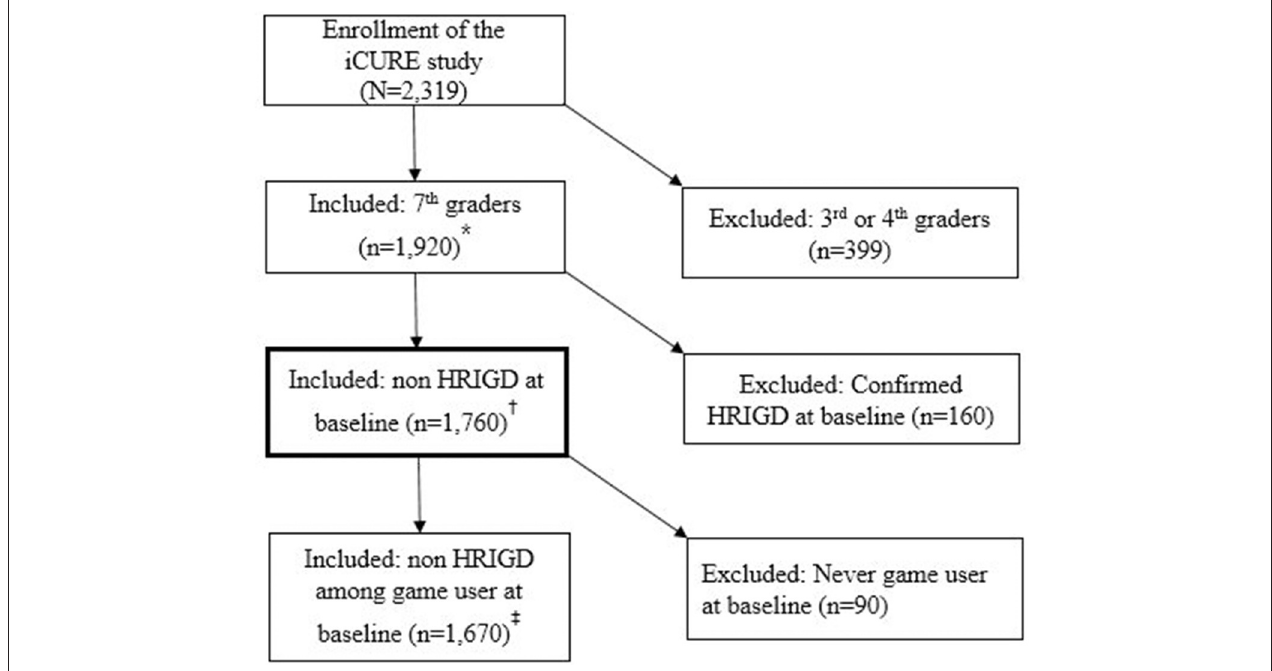
FIGURE 1 | Flow diagram of inclusion and exclusion criteria for the data analysis. *Sensitivity analysis set to evaluate effect of cumulative risk of early exposure to online game on HRIGD. † Main analysis set to evaluate the effect of early exposure to online game on incidence of HRIGD. ‡ Sensitivity analysis set to evaluate effect of early exposure to online game on incidence of HRIGD among game users at